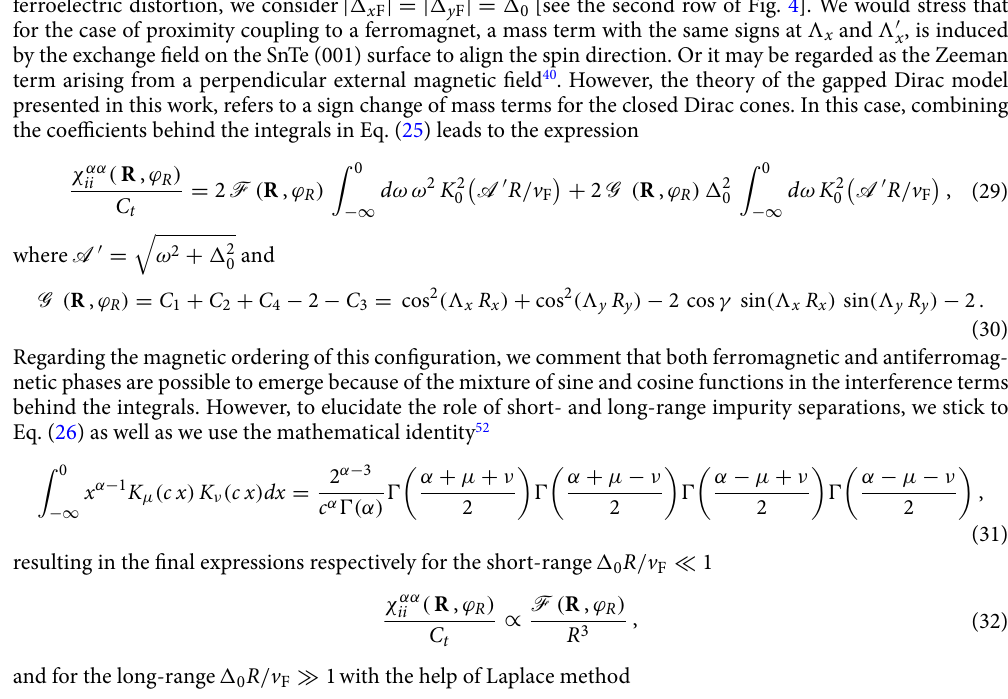
50 Å = 2 π) ( R , ϕ R J RKKY αα + =